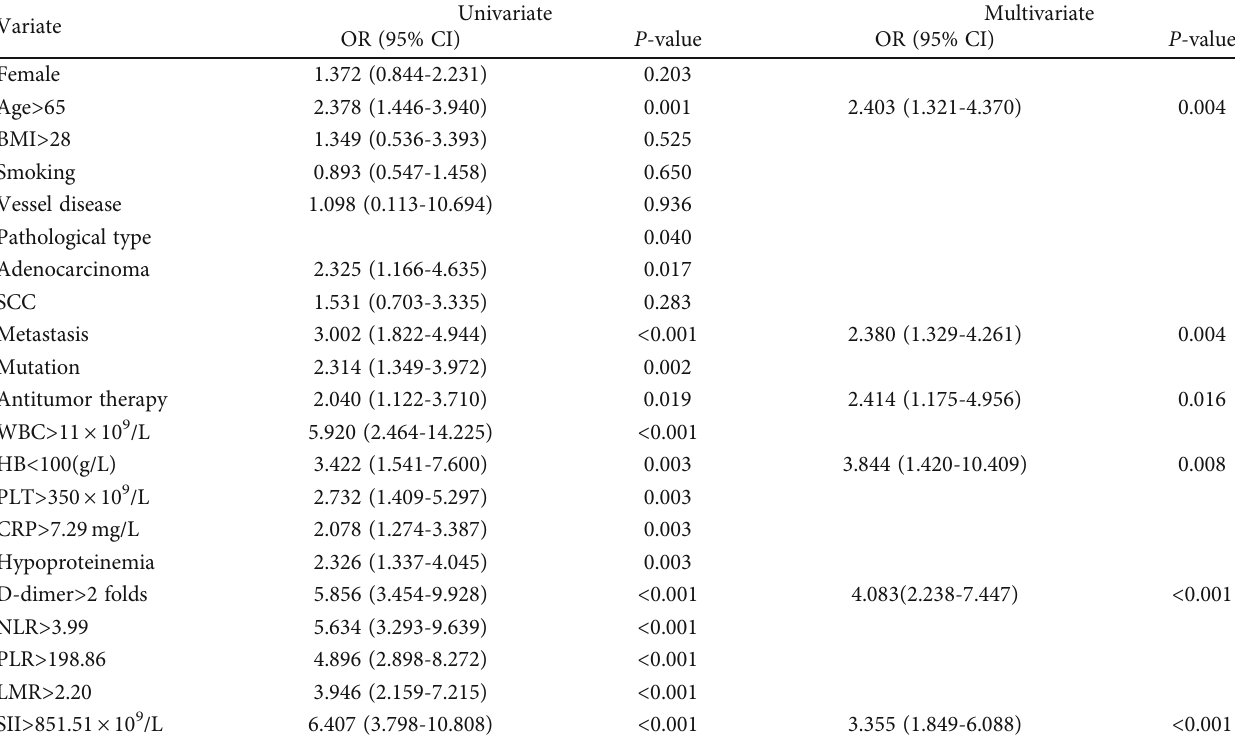
Figure 1: The receiver-operating characteristic (ROC) curve and the area under the ROC curve (AUC) of the systemic immune- in fl ammatory index (SII), neutrophil to lymphocyte ratio (NLR), platelet to lymphocyte ratio (PLR), and lymphocyte to monocyte ratio (LMR). The cut-o ff value of them was 851.51, 3.99, 198.86, and 2.20, respectively. Table 4: Comparison of clinical data between VTE groups and non-VTE